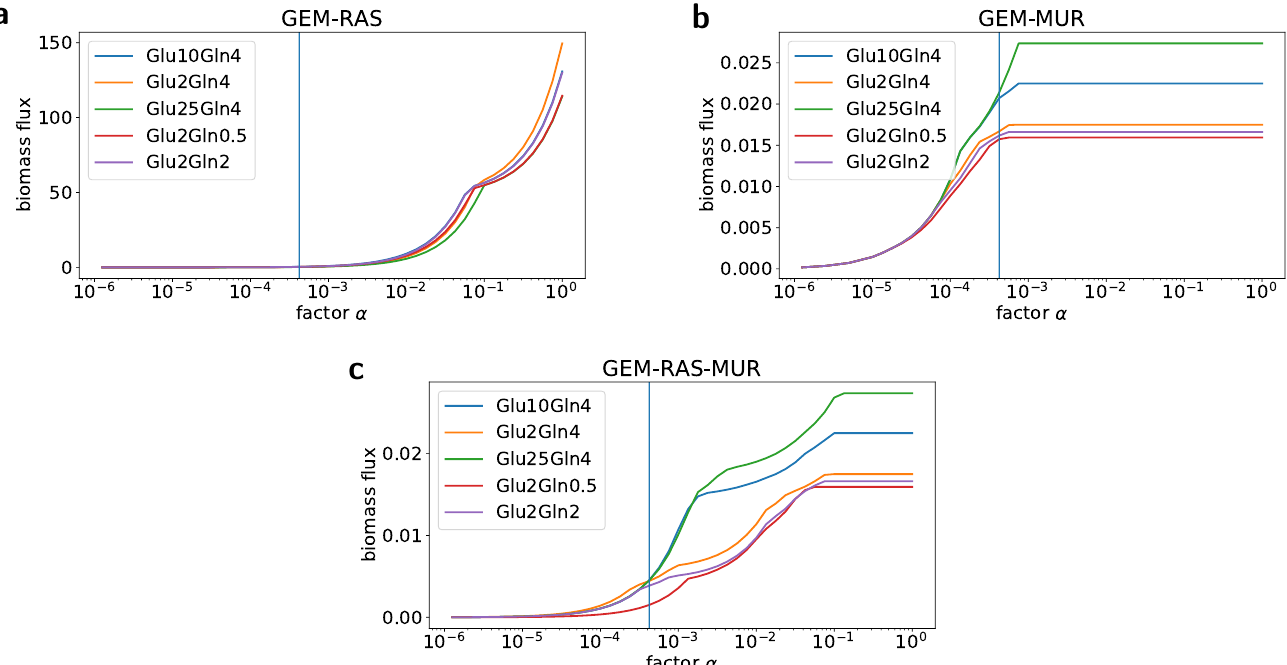
Figure 2. Dependencies between values of in silico biomass flux (y-axis) and values of the factor α (x-axis) for different combinations of genome-scale metabolic models (GEMs) with Reaction Activity Score (RAS) and Maximal Uptake Rate (MUR). ( a ) The dependency for GEM with RAS and without MUR. ( b ) The dependency for GEM with MUR and without RAS. ( c ) The dependency for GEM with RAS and MUR. In all plots, the blue vertical line denotes the value of α for which the best match between the predictions of the GEM-RAS-MUR and real measurements was